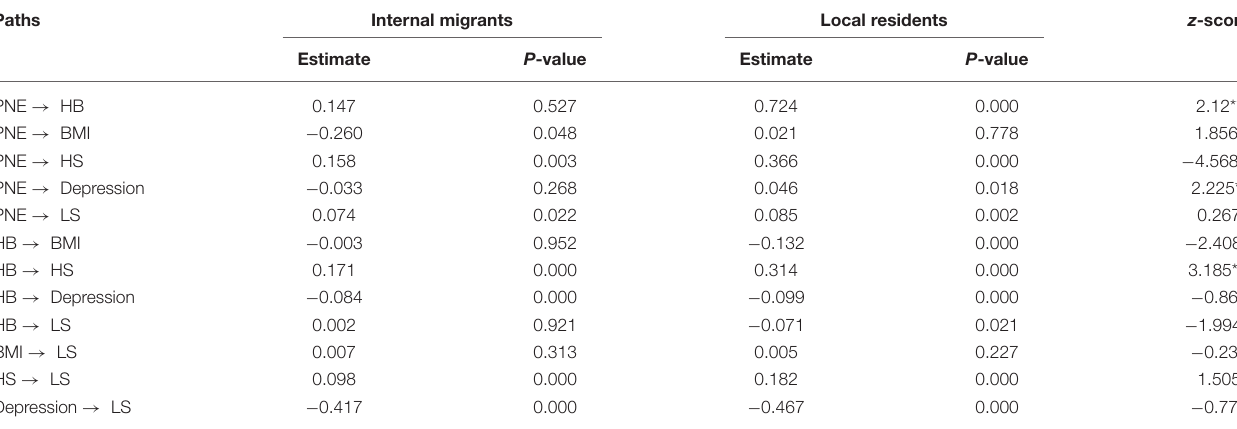
TABLE 7 | Results for moderating effects of urban hukou status.